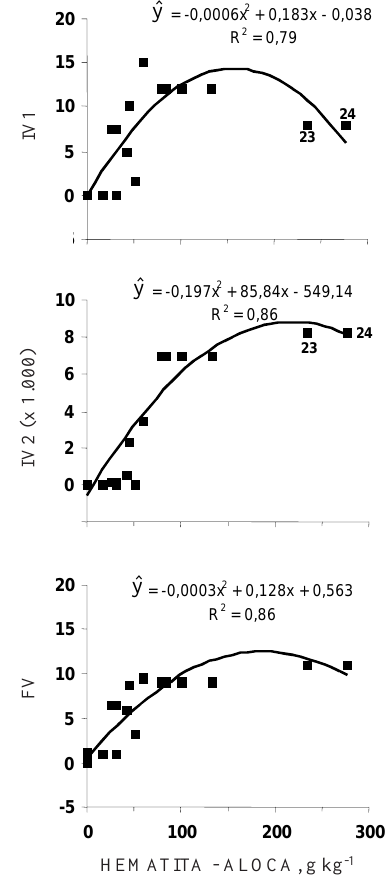
Figura 2. Relação entre índices de avermelhamento estimados a partir das observações de campo e teor de hematita. IV1 (Torrent et al., 1980); IV2 (Barrón & Torrent, 1986); FV: fator de avermelhamento (Santana,